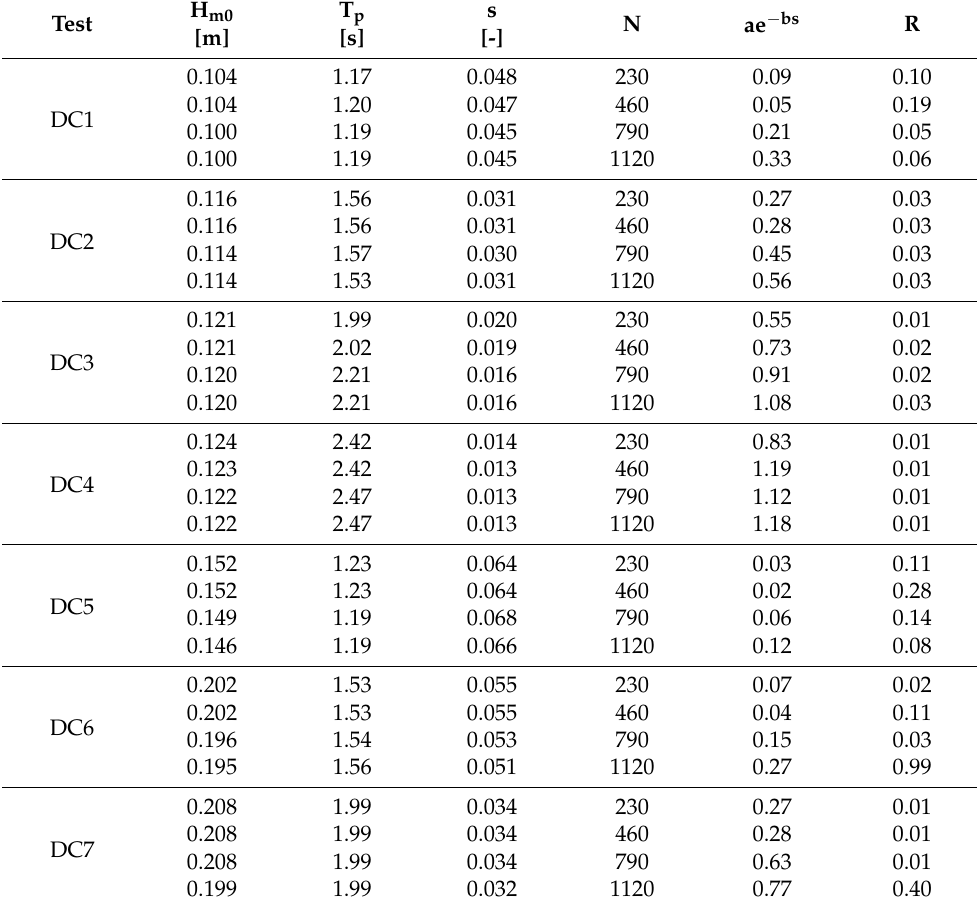
Table 7. Wave characteristics for DC tests, estimated a e ( − b s ) for DN tests and R for DC